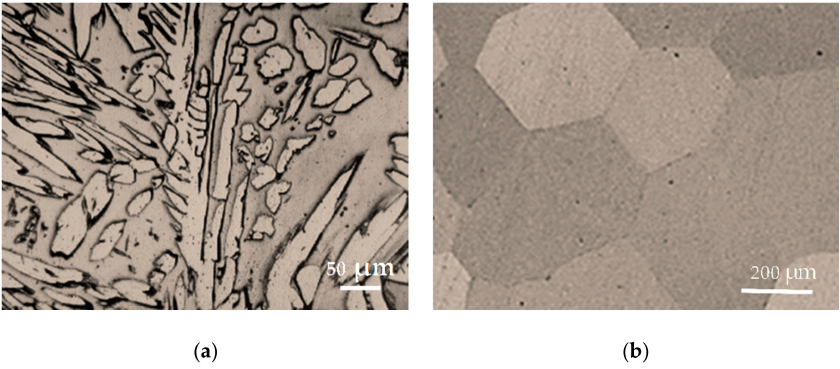
Figure 6. Microstructure of SMA: ( a ) as-cast state; ( b ) homogenized and quenched.